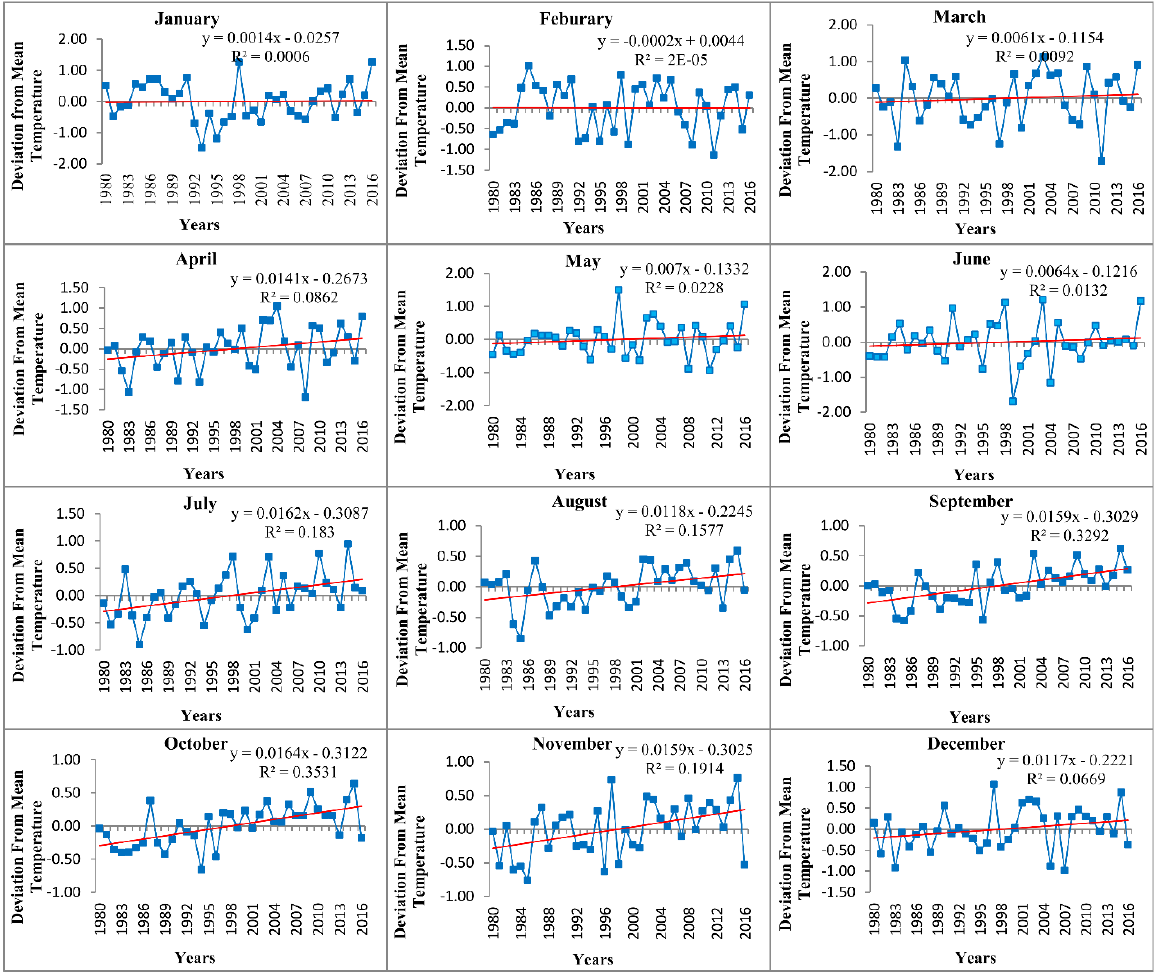
Figure 12. Monthly Temperature trends over coastal